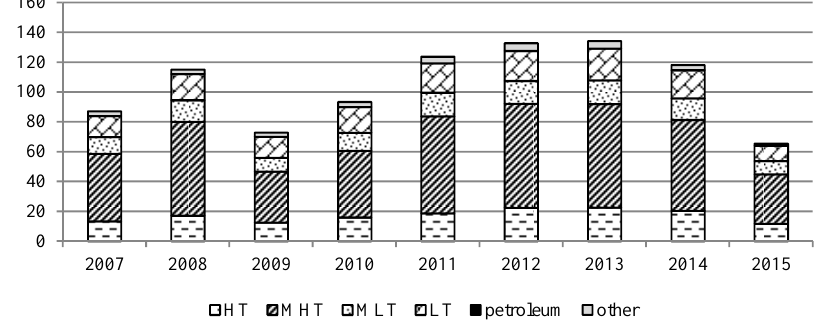
Figure 3. Goods structure of Russian imports from the EU28 in 2007–2015 (billion USD)